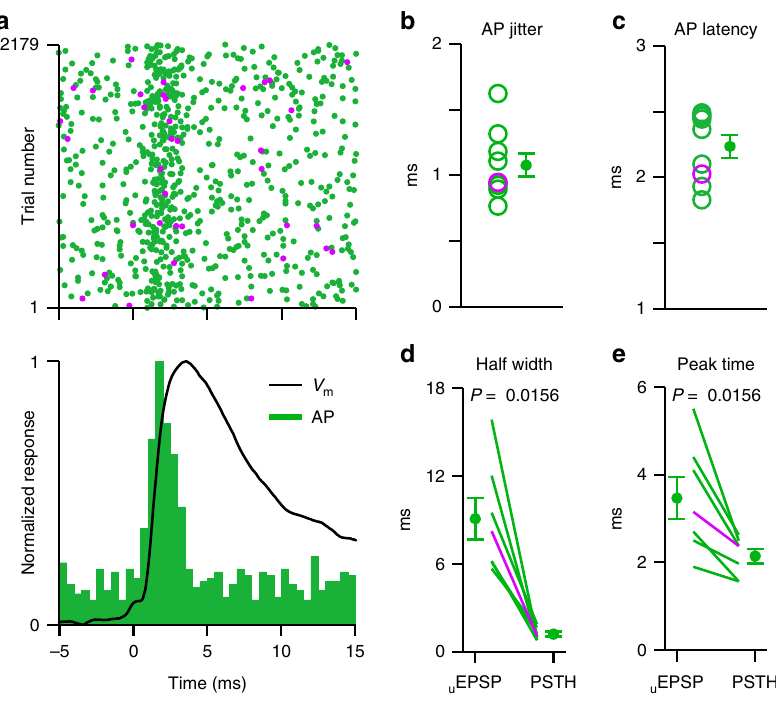
Fig. 5 Parvalbumin-expressing neuron action potentials are evoked during the rising phase of u EPSPs with millisecond precision. a Top, population raster plot (purple dots from awake mouse); bottom, normalized population PSTH (green) and normalized population u EPSP (black) from PV neurons ( n = 14) in response to evoked presynaptic PYR action potentials during UPstate. Note the short latency and temporal precision of the evoked PV neuron APs. b Jitter of evoked PV neuron APs, open circles represent single connection, purple circle shows connection in an awake mouse, fi lled circle with error bars shows mean ± s.e.m. ( n = 9). c Latency of evoked PV neuron APs ( n = 9). d Comparison of the evoked PSTH and u EPSP half-width, lines show individual cells, purple line shows awake recording ( n = 7). e Same as d , but for the peak time ( n =